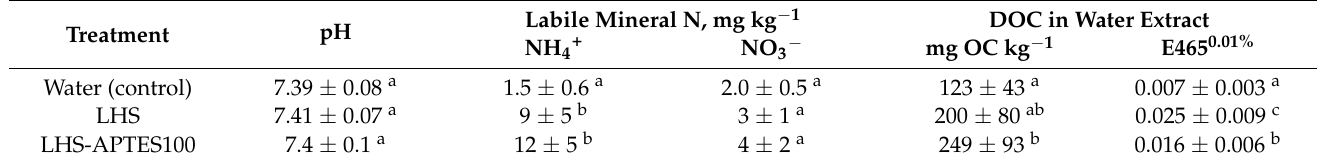
Table 4. The properties of soil treated with different amendments.